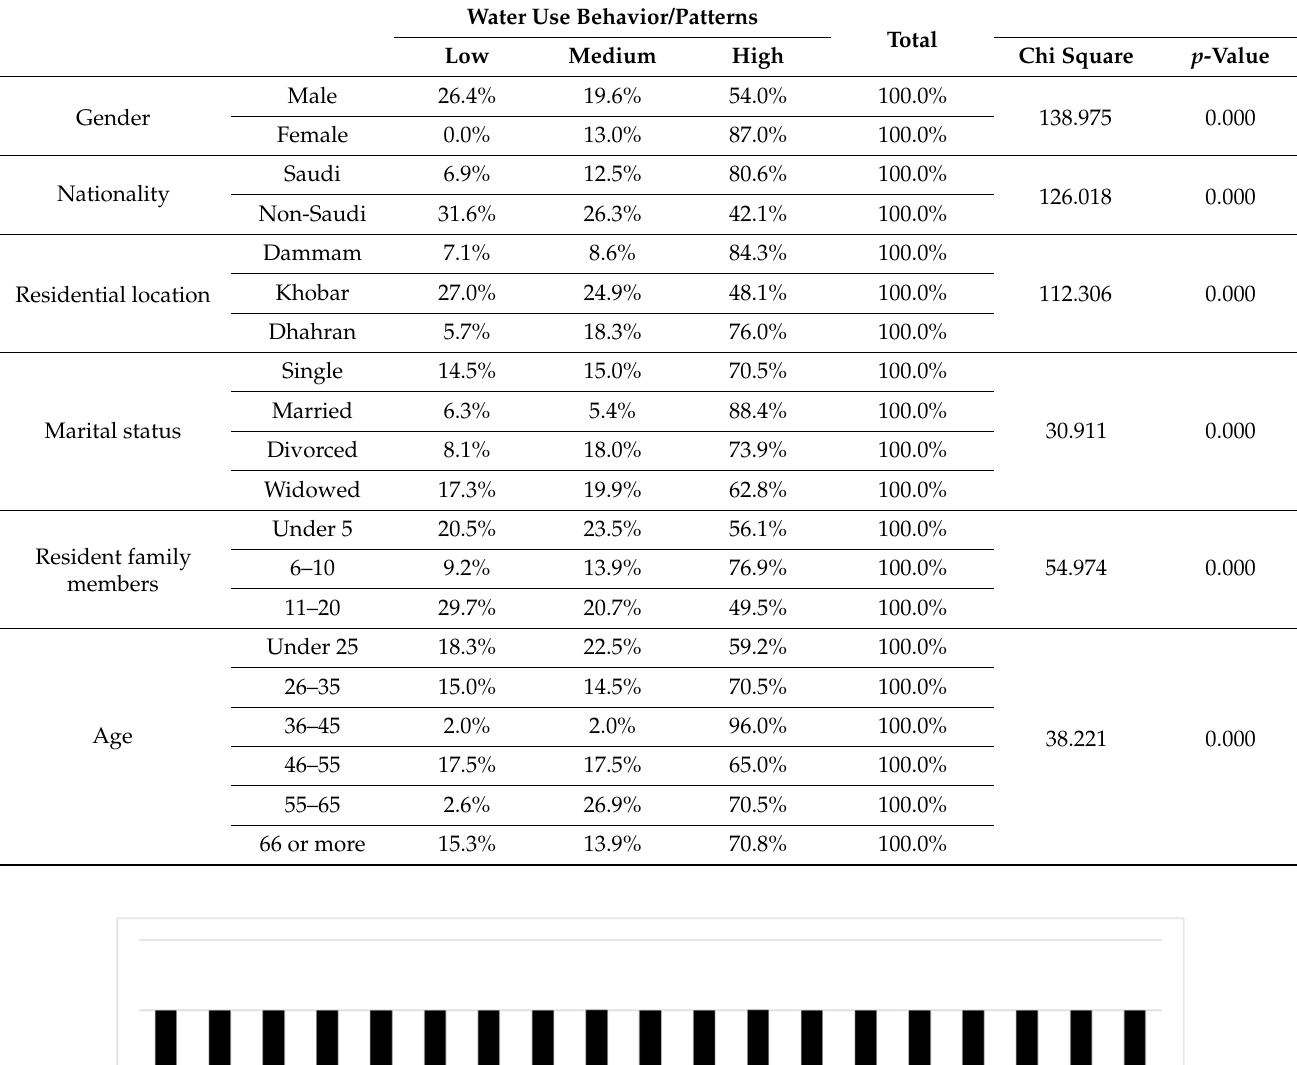
Table 3. Association between demographic features and water-use behavior/patterns.